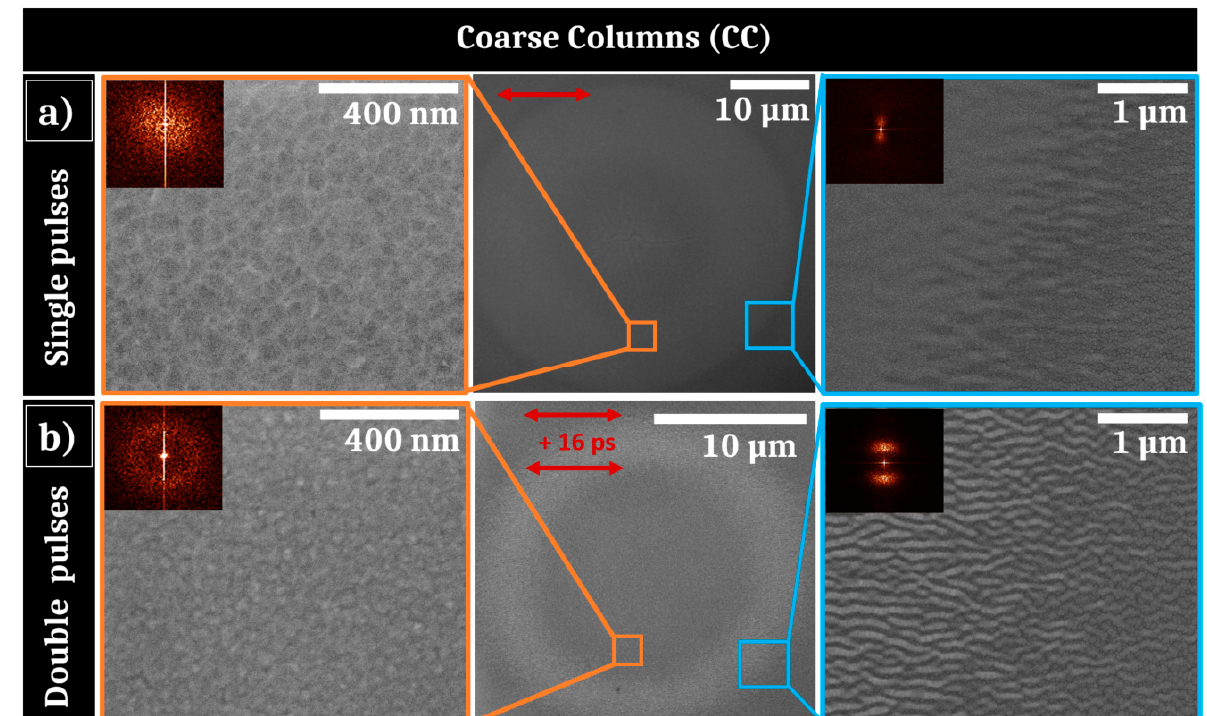
Figure 6. ( a ) SEM pictures of irradiated area of the Coarse Columns sample after 50 single pulses of laser irradiation with 0.06 J/cm 2 with 2D-Fourier transform as insets; ( b ) SEM pictures of irradiated area after 50 double pulses of laser irradiation separated by 16 ps with a total fluence of 0.06 J/cm 2 with 2D-Fourier transform as insets. The red arrows represent the electric field